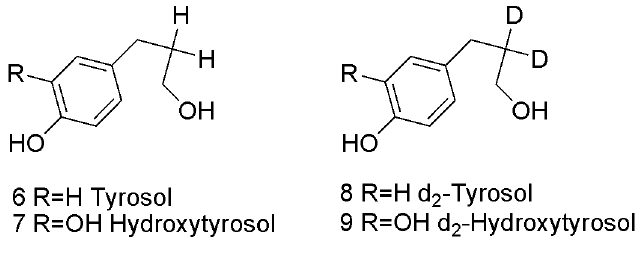
Figure 2 . MS/MS spectrum of the protonated molecular ion of hydroxytyrosol and d